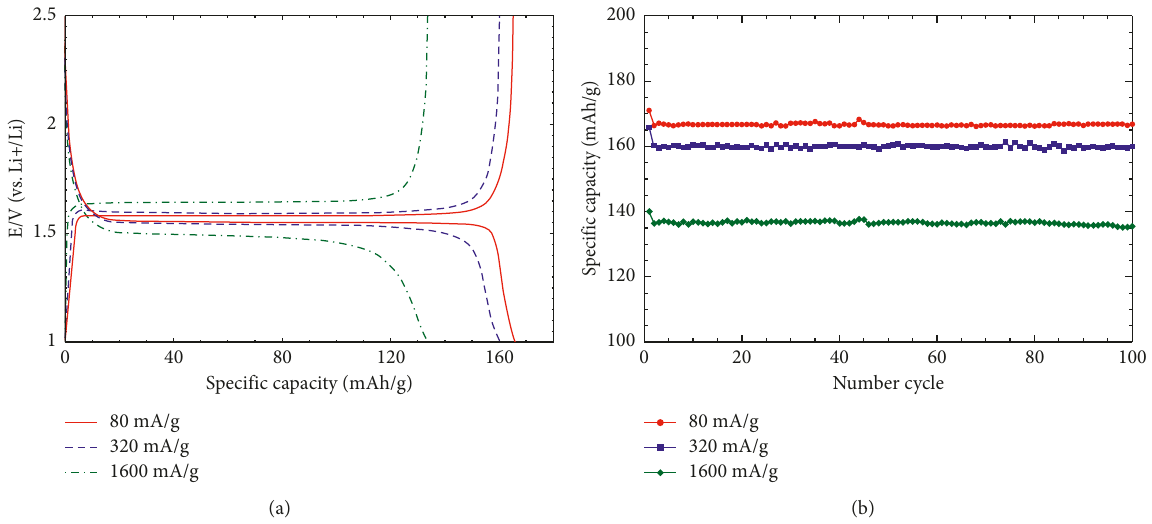
Figure 6: (a) Typical charge-discharge curves at current density: 80, 320, and 1600mA/g and (b) cycling performance of Li